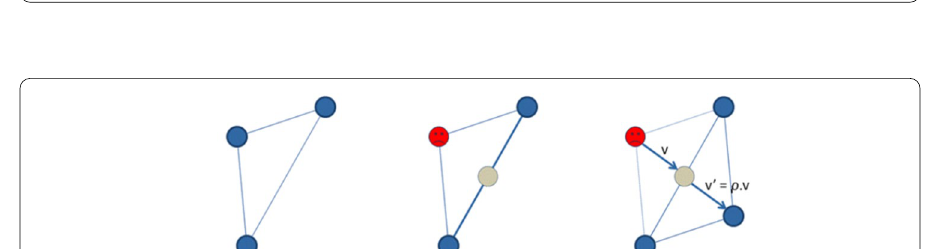
Fig. 7 Evolution process for two parameters case